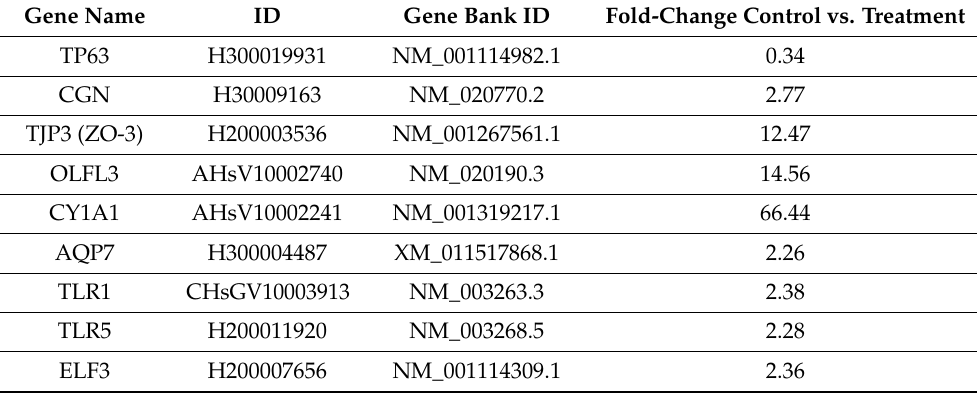
Table 1. List of gene probes up- or downregulated in A253 cells transfected with siRNA-p63 in the presence of EW-7197 and